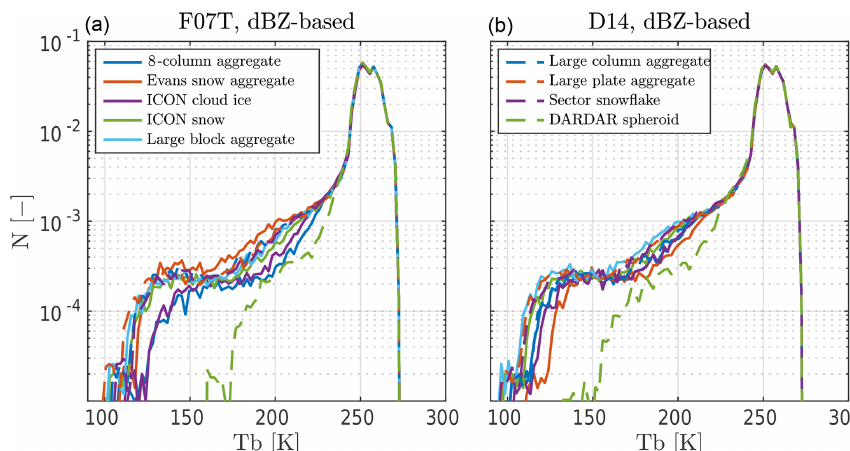
Figure 11. As in Fig.10c and d, but for 668.2GHz and with D14 PSD used in panel (b)